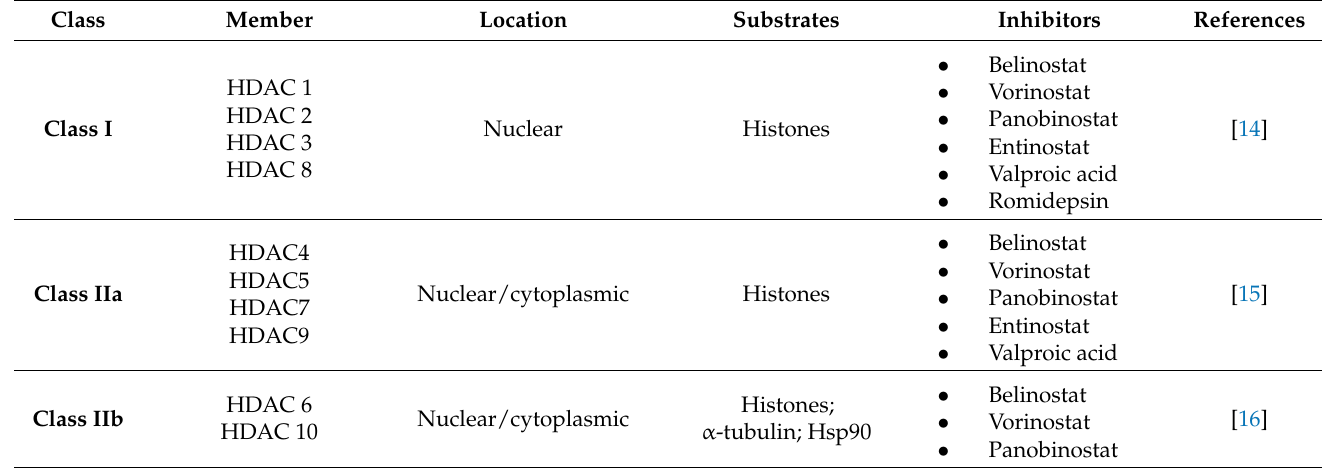
Table 1. Classification of Histone deacetylases (HDACs) according to the down-target substrates and their cellular